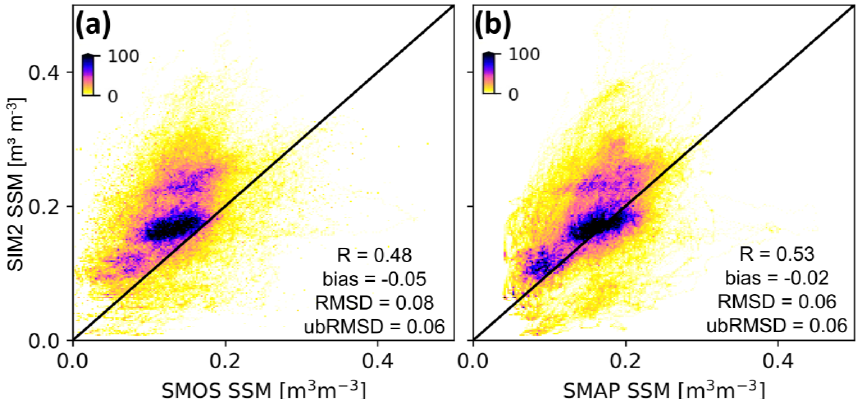
Figure 3. Density scatterplots comparing the SIM2 SSM climatology (median climatology across the GCMs), against a reference climatology based on (a) SMOS retrievals and (b) SMAP retrievals (April 2015–2020). Only the period from 1 March to 31 October is considered. The color bars represent the number of space–time samples per bin. Spatiotemporal skill metrics ( R , bias, RMSD, and ubRMSD) are shown.